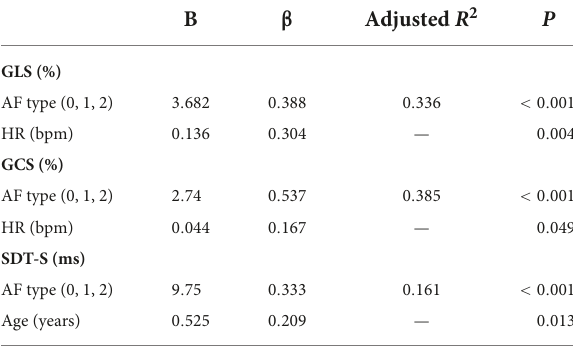
TABLE 7 Stepwise multivariate regression analysis of GLS, GCS and